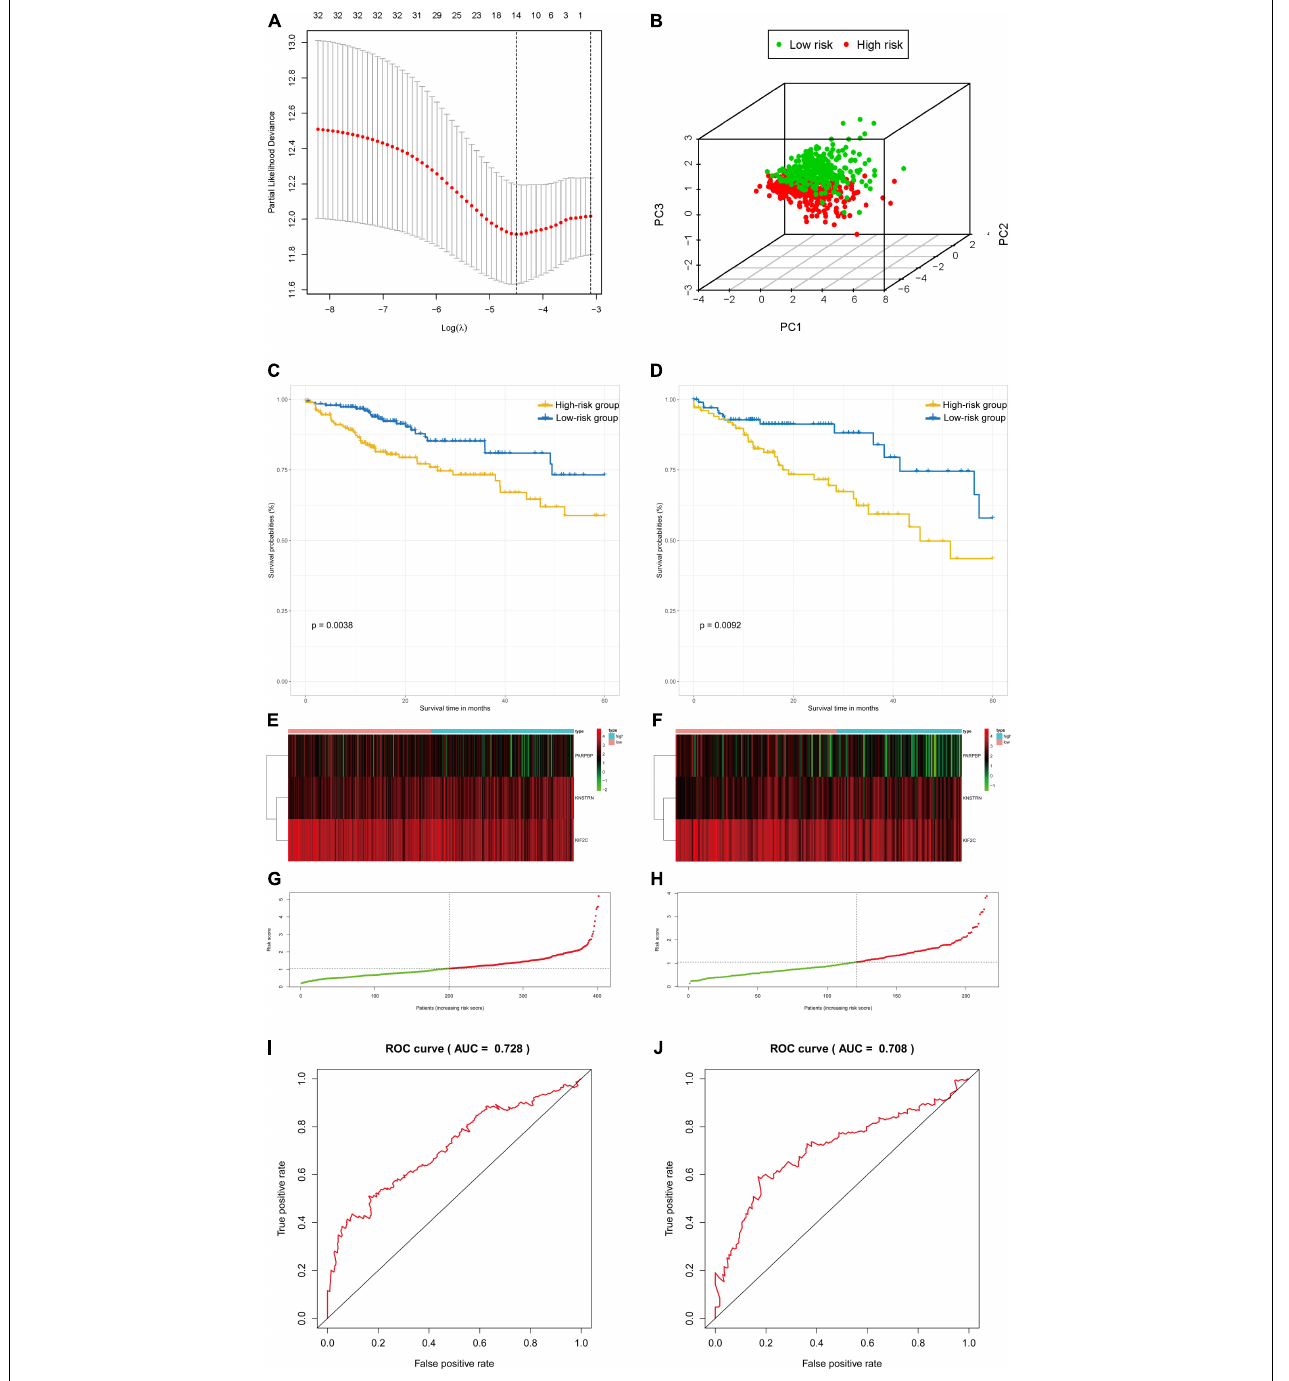
FIGURE 5 | The survival analysis and prognostic performance of the three-gene signature of colon and rectal cancer. (A) Lasso of the risk score for colon and rectal cancer between high-risk and low-risk patients in the training group. (B) PCA of the risk score for colon and rectal cancer between high-risk and low-risk patients in the training group. (C) The Kaplan–Meier test of the risk score for the overall survival of colon and rectal cancer between high-risk and low-risk patients in the training group (log-rank test, p < 0.001). (D) The prognostic value of the risk score shown by the time-dependent receiver operating characteristic (ROC) curve for predicting the 5-year overall survival training group. (E) Risk score curve of the three-gene signature of colon and rectal cancer in the training group. (F) Heatmap showed the expression of three genes by risk score of colon and rectal cancer in the training group. (G) The Kaplan–Meier test of the risk score for the overall survival of colon and rectal cancer between high-risk and low-risk patients in the testing group (log-rank test, p < 0.001). (H) The prognostic value of the risk score shown by the time-dependent ROC curve for predicting the 5-year overall survival in the testing group. (I) Risk score curve of the three-gene signature of colon and rectal cancer in the testing group. (J) Heatmap showed the expression of three genes by risk score of rectal cancer in the testing group.